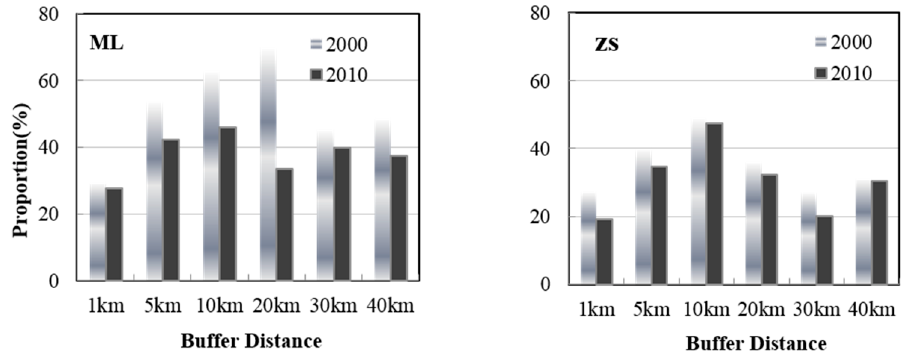
Figure 6. Arable land proportion within each buffer region between 2000 and 2010.